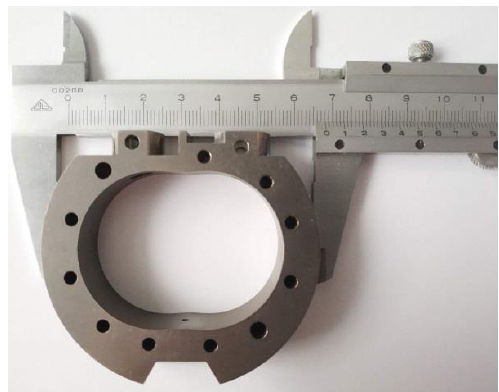
Figure 13. The cylinder without microtextures.